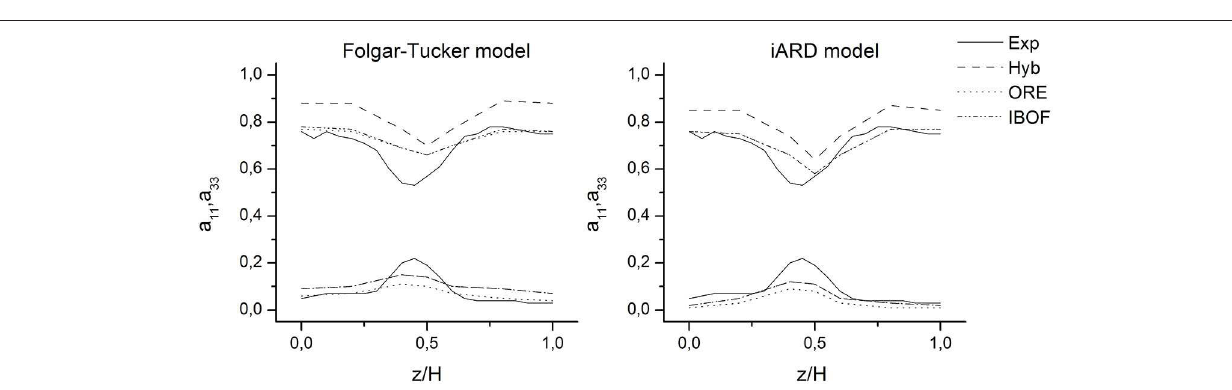
FIGURE 6 | Experimental and predicted a 11 and a 33 profiles at the filling completion region